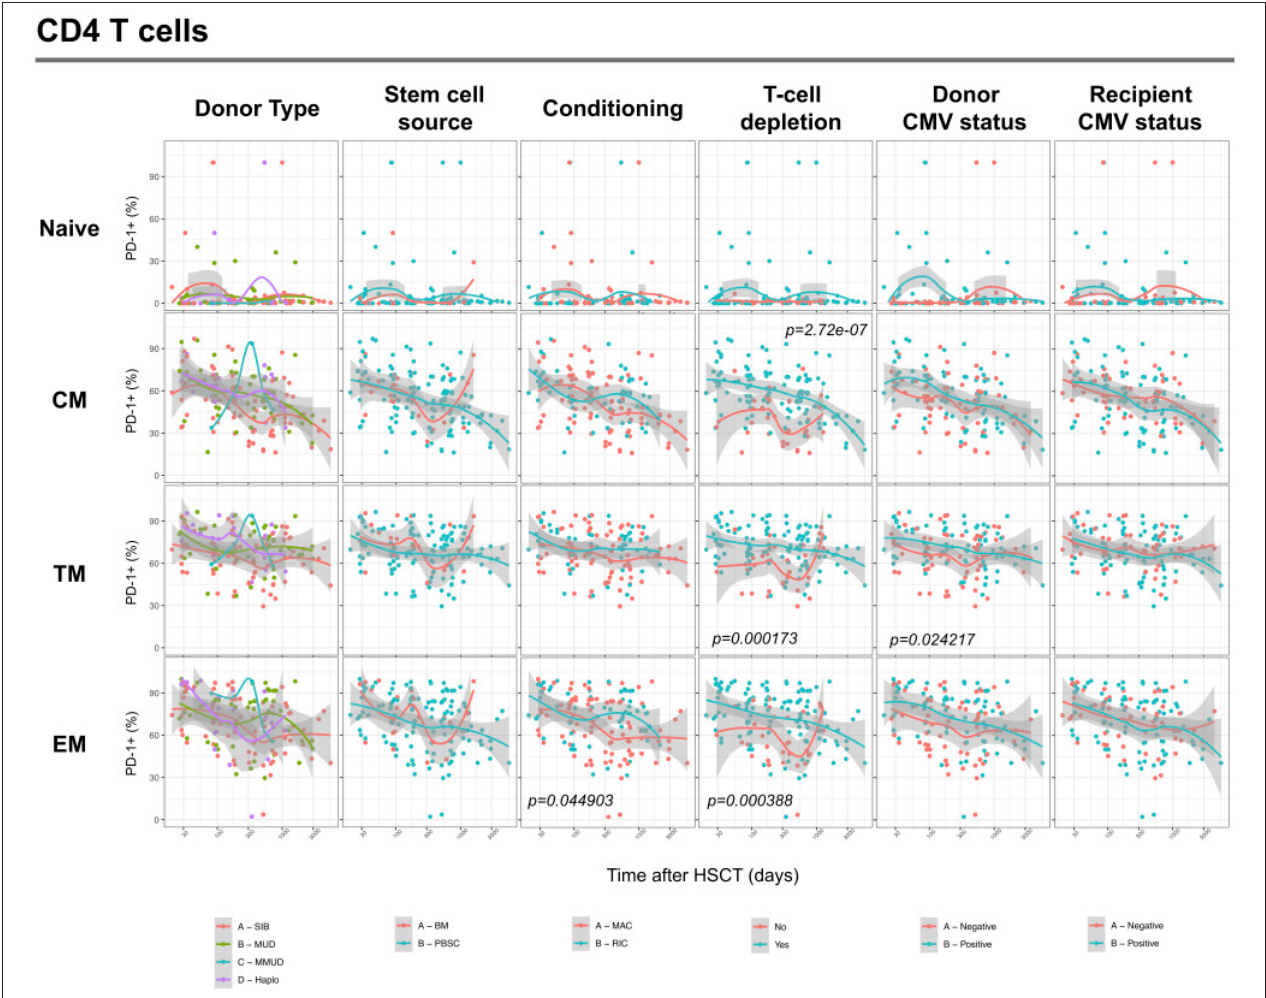
FIGURE 5 | Impact of clinical factors on PD-1 expression at CD4T cell subsets surface after allogeneic HSCT. Comparison of PD-1 expression on CD4T cell subsets from HSCT recipients depending on donor type, stem cell source, conditioning, T-cell depletion and donor/recipient CMV status. The p -values resulting from the multivariable linear regression analysis are indicated when